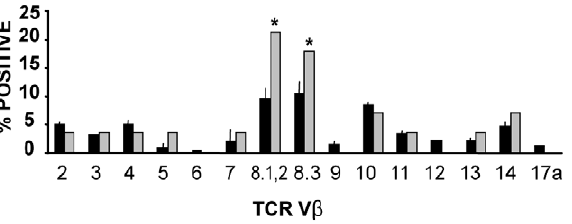
Figure 1. Phenotypic characterization of spontaneous thymic lymphomas. The expected versus observed frequency of spontaneous thymic lymphomas expressing specific V b determinants. Single cell suspensions from individual AKR/J lymphomas or from the thymus of 3 mo-old AKR/J normal mice were stained with a panel of anti-V b specific MoAbs and analyzed by FACS. The black bars represent the expected frequency calculated as the mean 6 standard deviation of the percentage of thymocytes from 3 mo-old AKR/J normal mice (n=5) that bind a particular anti-V b MoAb. The grey bars represent the observed frequency of lymphomas that bind the indicated anti-V b MoAb (n= 28). Asterisks mark the V b determinants that were represented on lymphomas at significantly greater than expected frequencies (* p , 0.05).